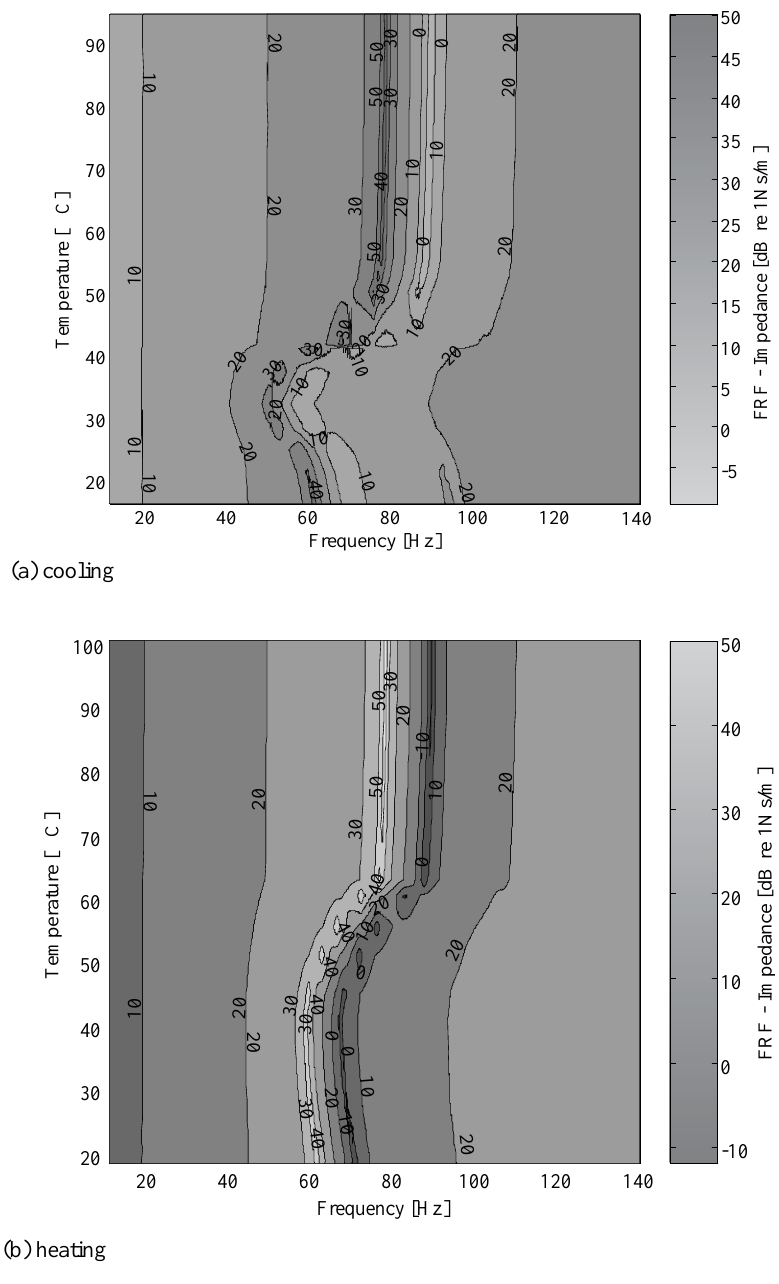
Fig. 12. Mechanical impedance of the SMA ATVA during cooling and